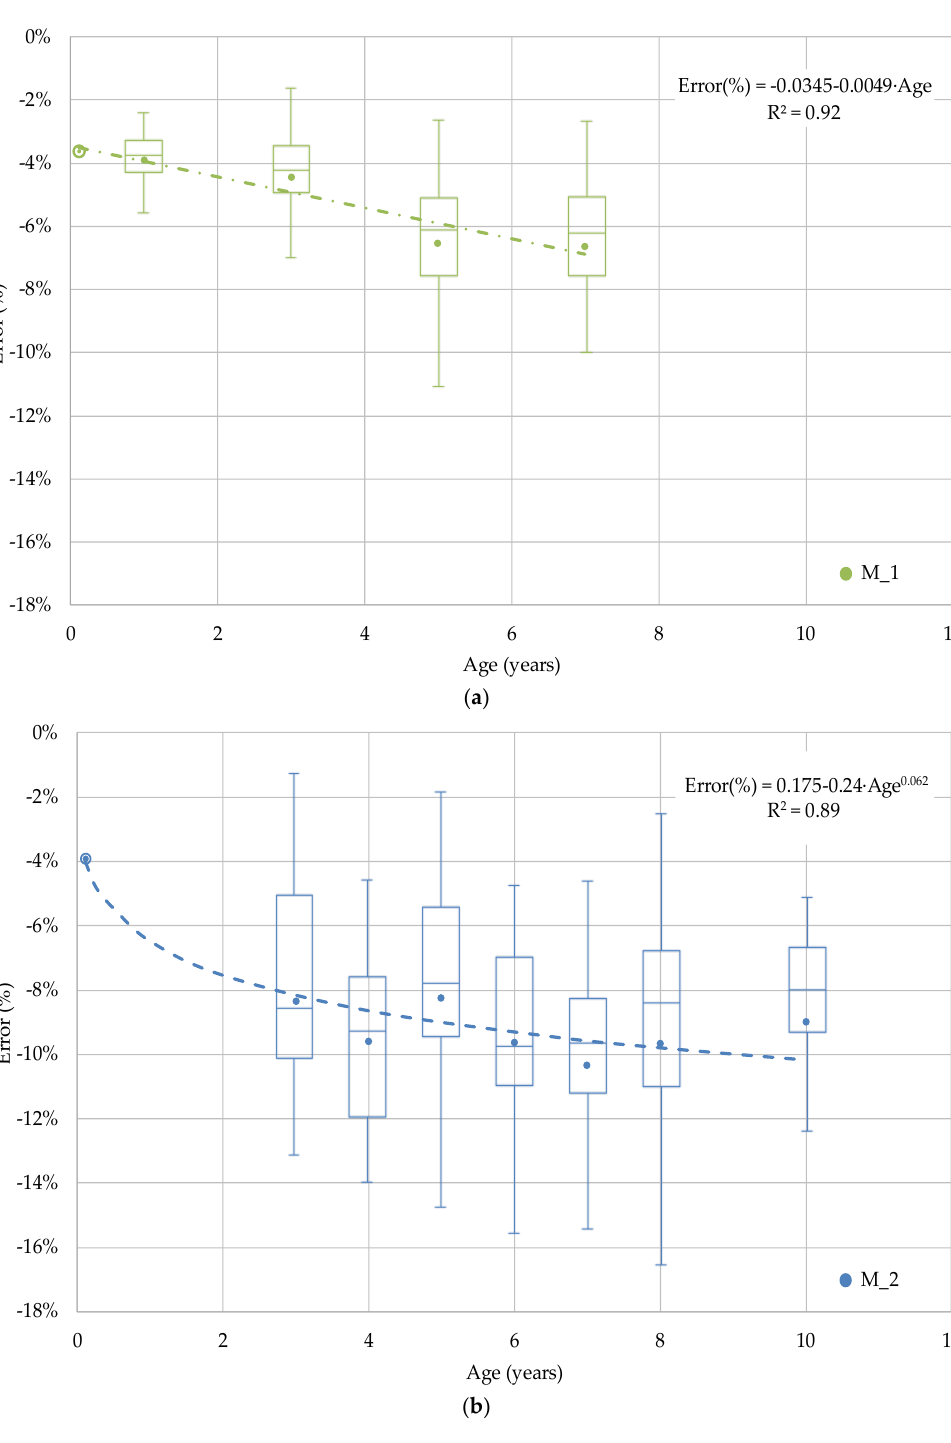
Figure 3. The degradation rate of the weighted error with age: ( a ) meter M_1; ( b ) meter M_2.